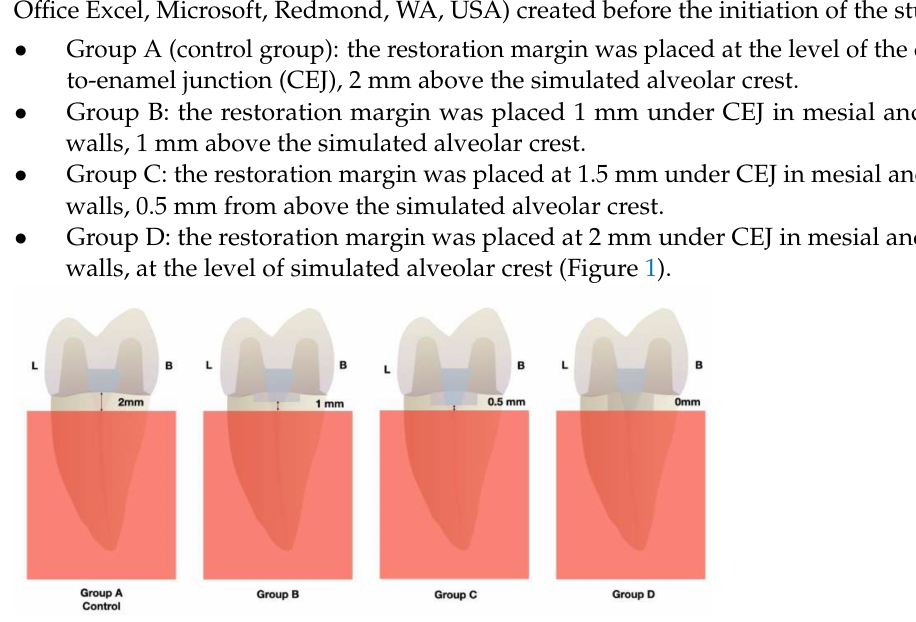
Figure 1. Proximal view of the different locations of the restorative margin in the different treat- ment